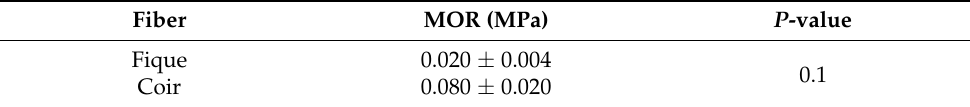
Table 7. Modulus of rupture of panels.